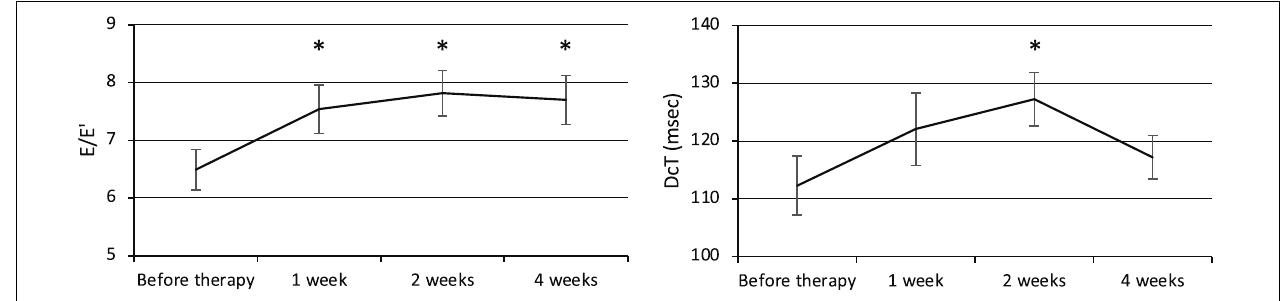
FIGURE 3 | Changes in diastolic function (E/E (cid:48) and DcT). E, Left ventricular early diastolic inflow velocity. E (cid:48) , Early diastolic mitral annual velocity. A, Late diastolic mitral flow due to atrial contraction. DcT, Deceleration time of E wave. ∗ p < 0.05 for comparisons with pretherapy values. The line graph connects the mean values, and the error bars show the standard error ranges. The E/E (cid:48) increased after 1 week, and the DcT was prolonged after 2